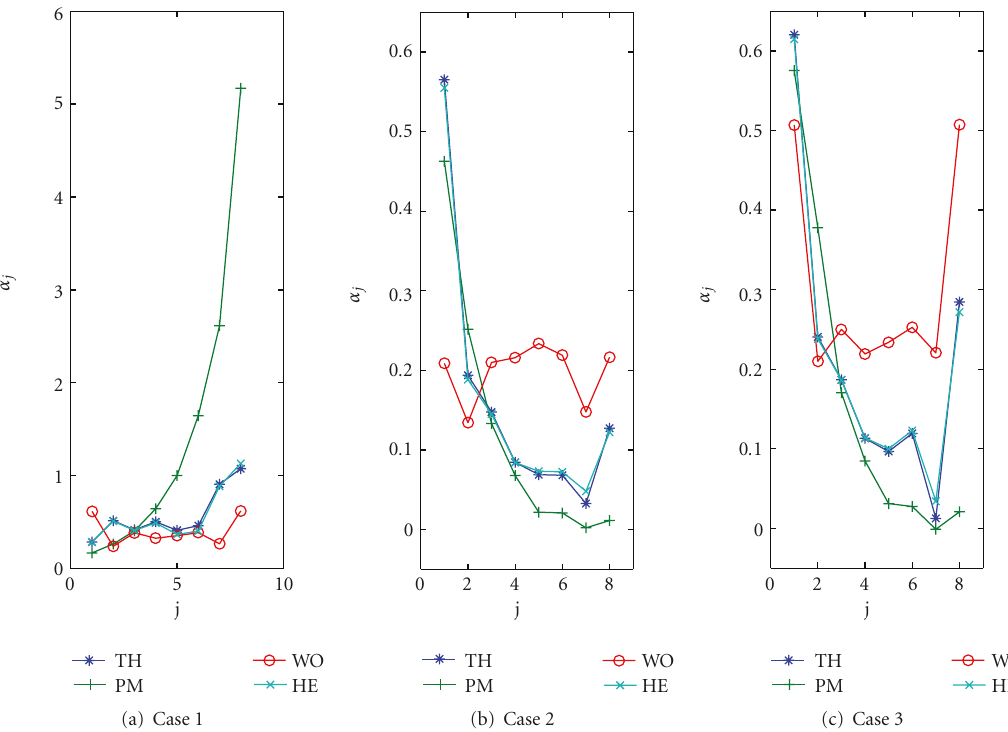
Figure 5: The optimized weighting factors for the bandlimited peaked spectrum process when the di ff erent multiple window sets are applied to the di ff erent cases, and Thomson windows (stars), Peak Matched multiple windows (pluses), Welch method (circles), and Hermite functions (crosses): (a) stationary process, (b) long-event nonstationary process, and (c) short-event nonstationary process.